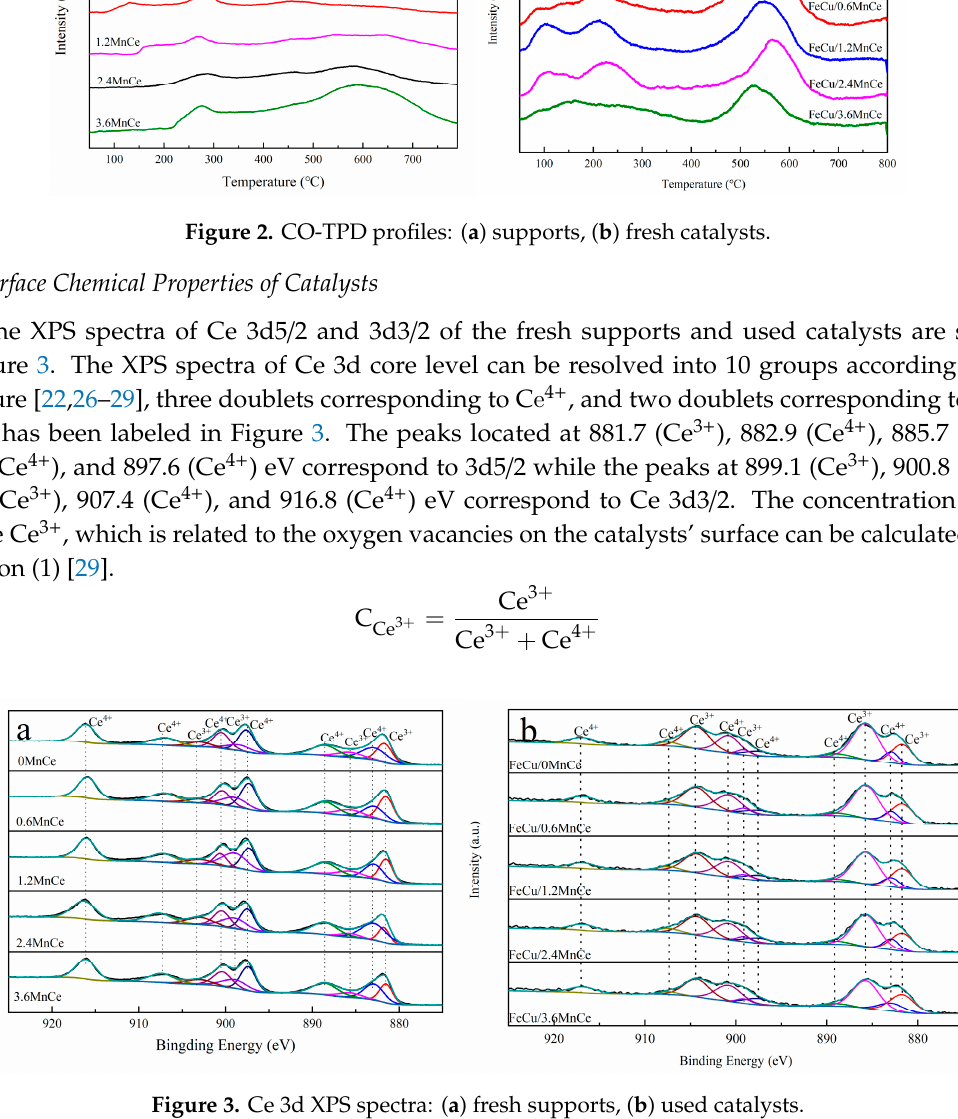
Figure 3. Ce 3d XPS spectra: ( a ) fresh supports, ( b ) used catalysts.